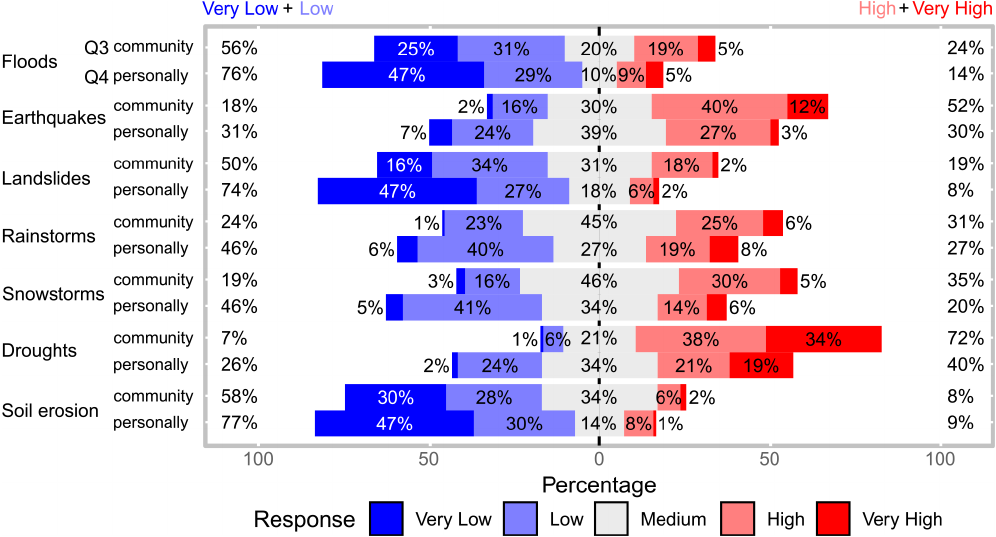
Figure 3. The Likert plot of the stakeholders’ responses regarding the perceived threat of natural hazards to the community (Q3) and their own person/household/income (Q4).